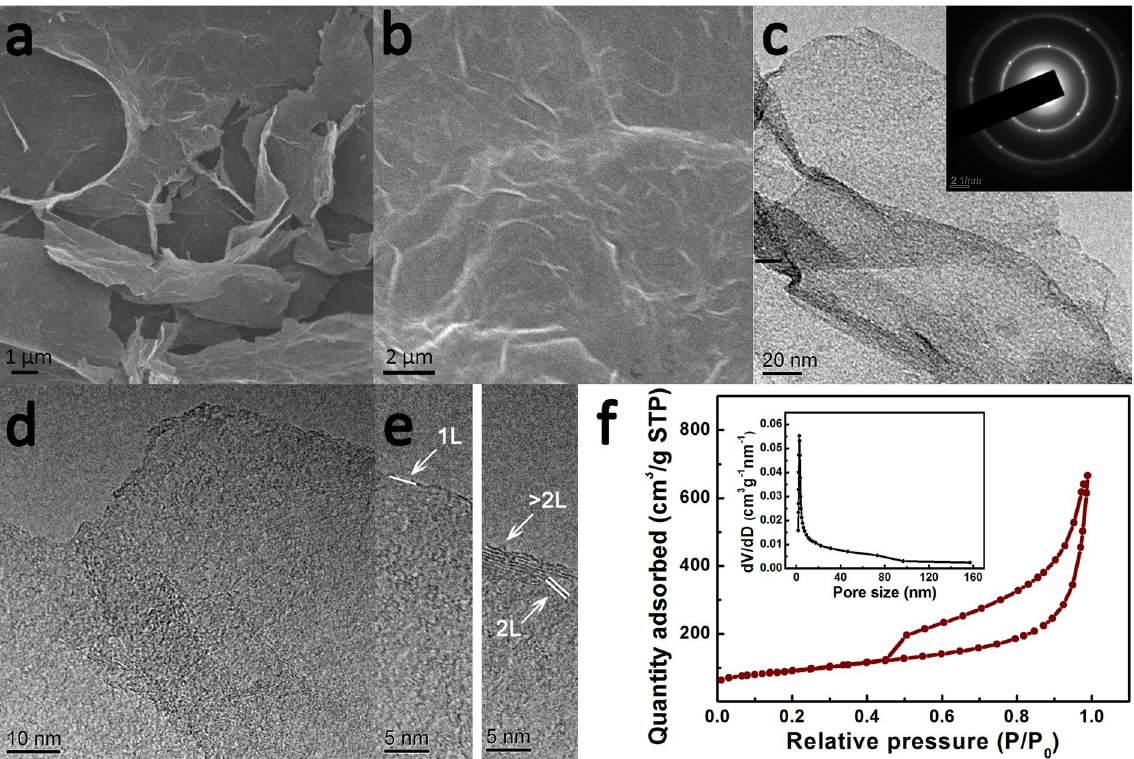
Figure 2. ( a , b ) FESEM images of N-doped graphene aerogel; ( c ) TEM image of N-doped graphene aerogel, the inset of ( c ) is the corresponding SAED pattern; ( d , e ) HRTEM images of N-doped graphene aerogel; ( f ) Isotherm plot and BJH pore distribution (inset) of N-doped graphene